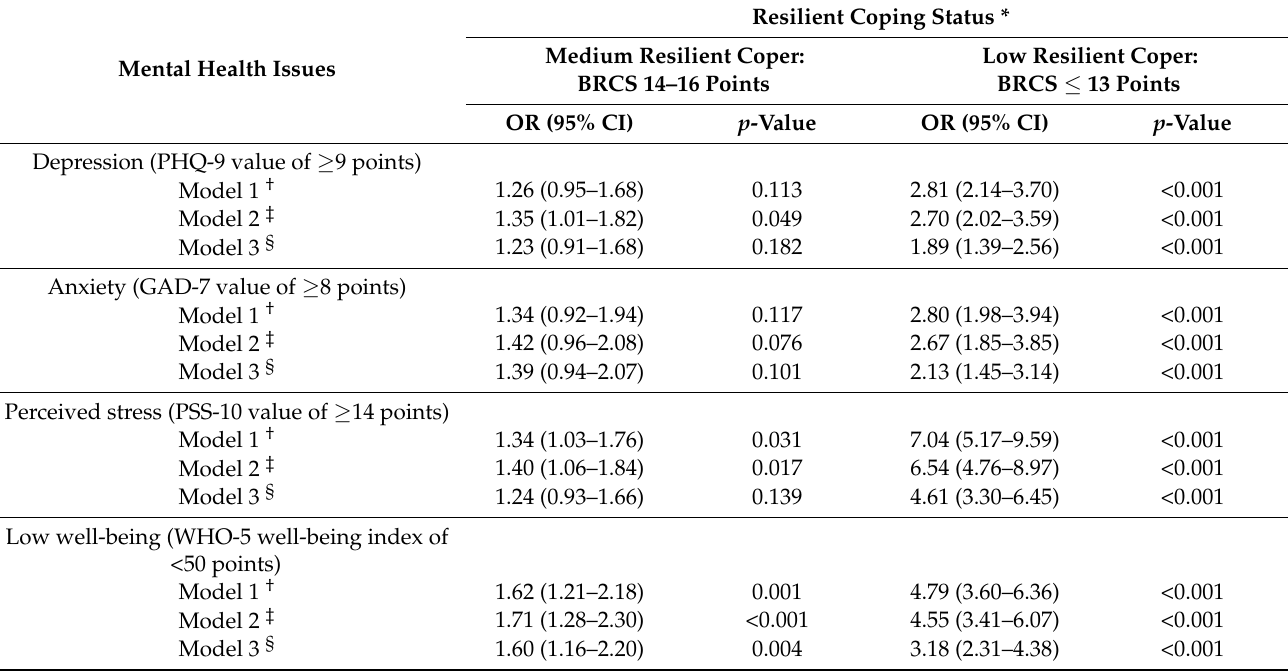
Table 4. Resilient coping status and the risk of mental health issues during the COVID-19 pandemic in Thailand: Multivariable logistic regression